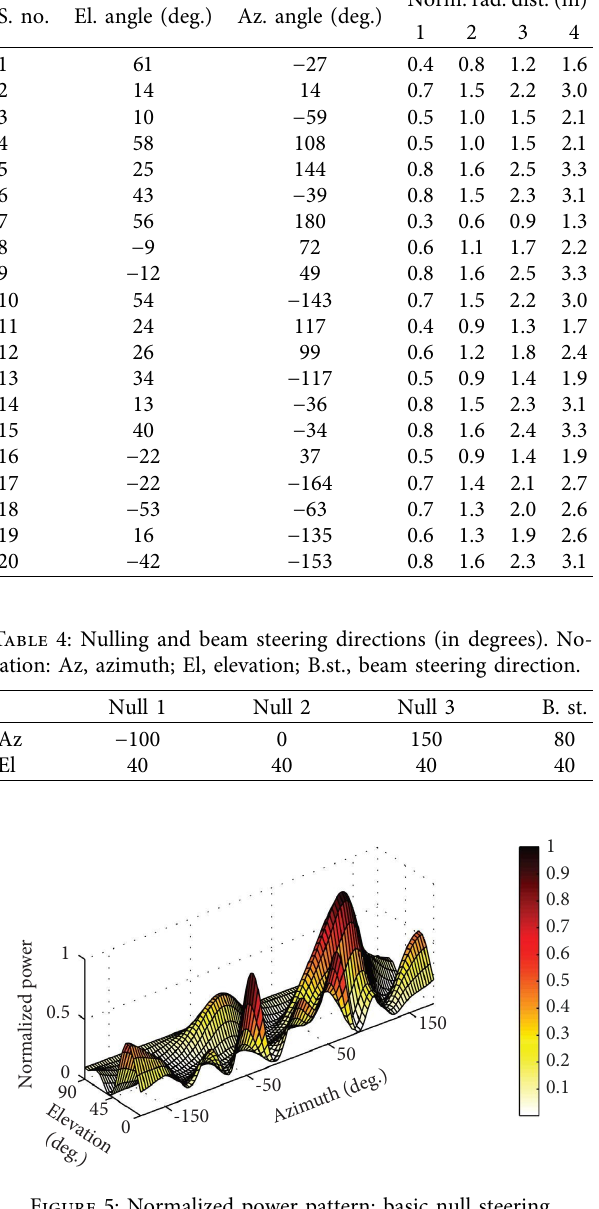
Figure 5: Normalized power pattern: basic null steering.